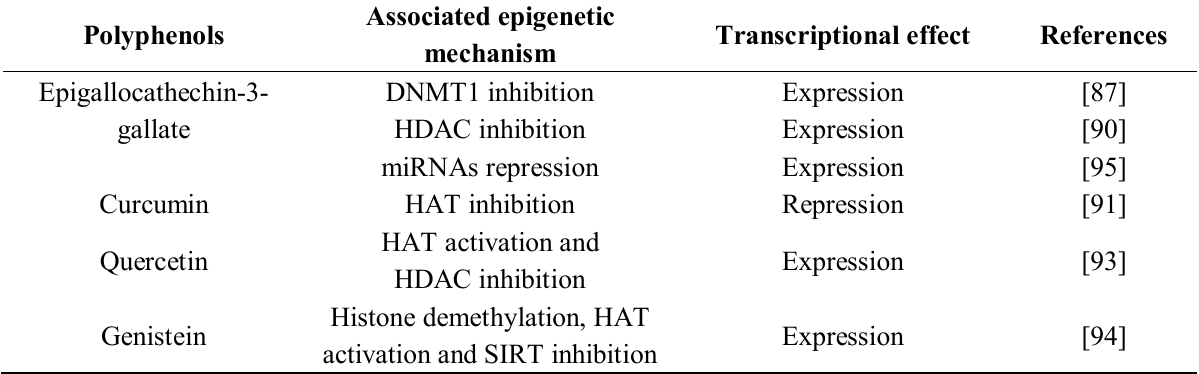
Table 1. Epigenetic mechanisms regulated by